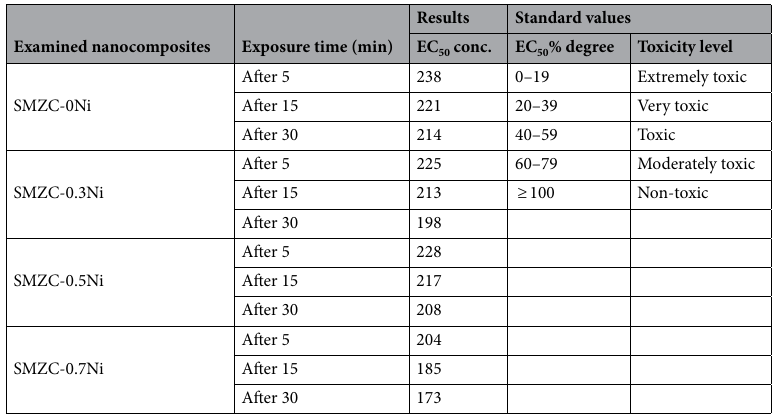
Table 3. The values of effective concentrations EC50 (mg/L) after 5, 15, and 30 min of exposure to examined nanocomposites.